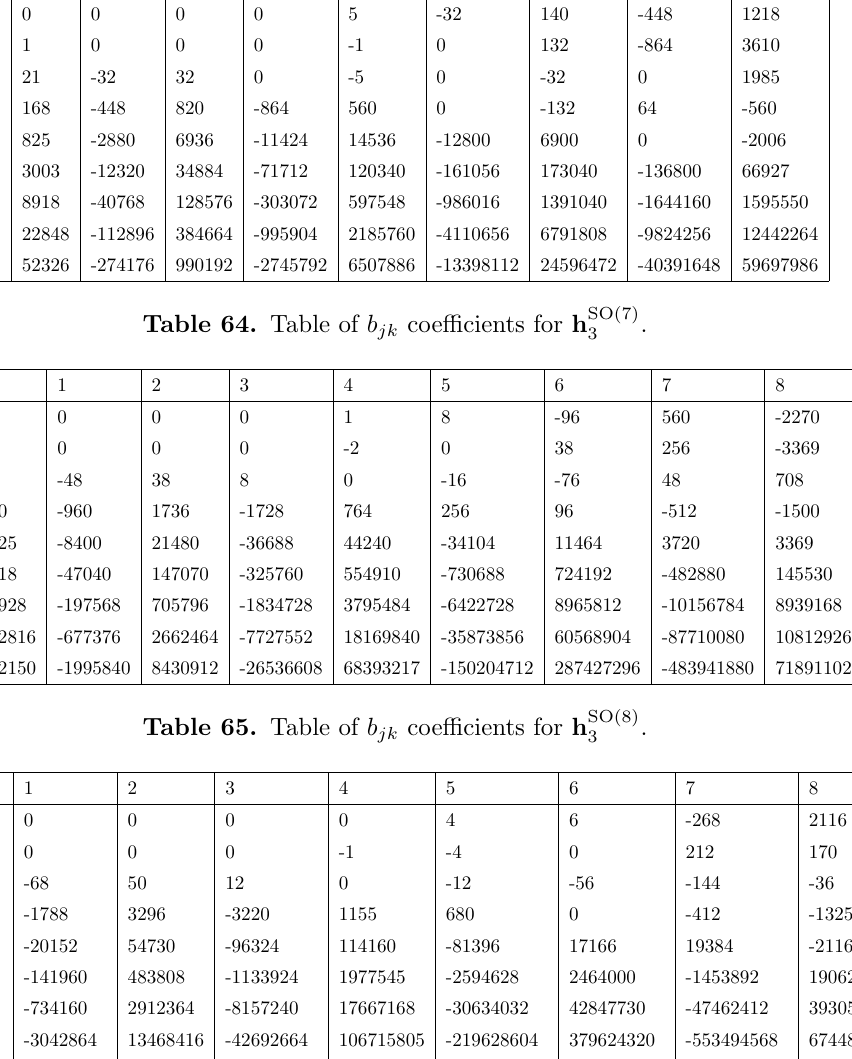
Table 66. Table of b jk coe(cid:14)cients for h SO(9)